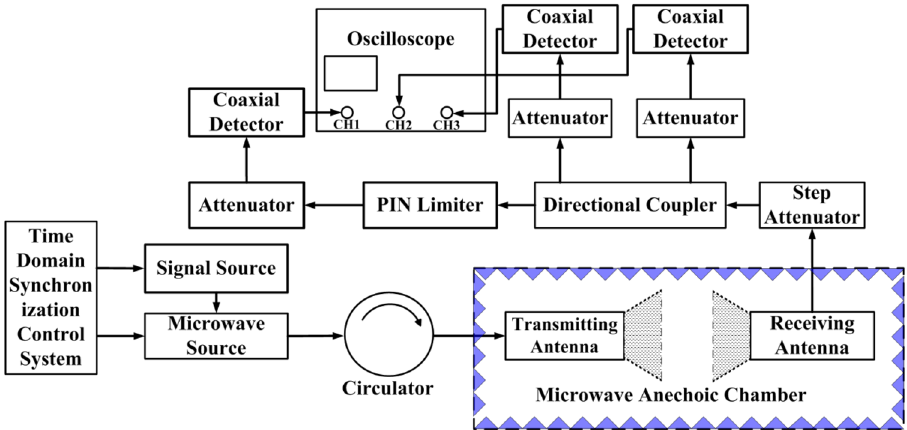
Figure. 6. Schematic diagram of the measurement system employed for studying the thermal burnout effect on PIN diode limiters.